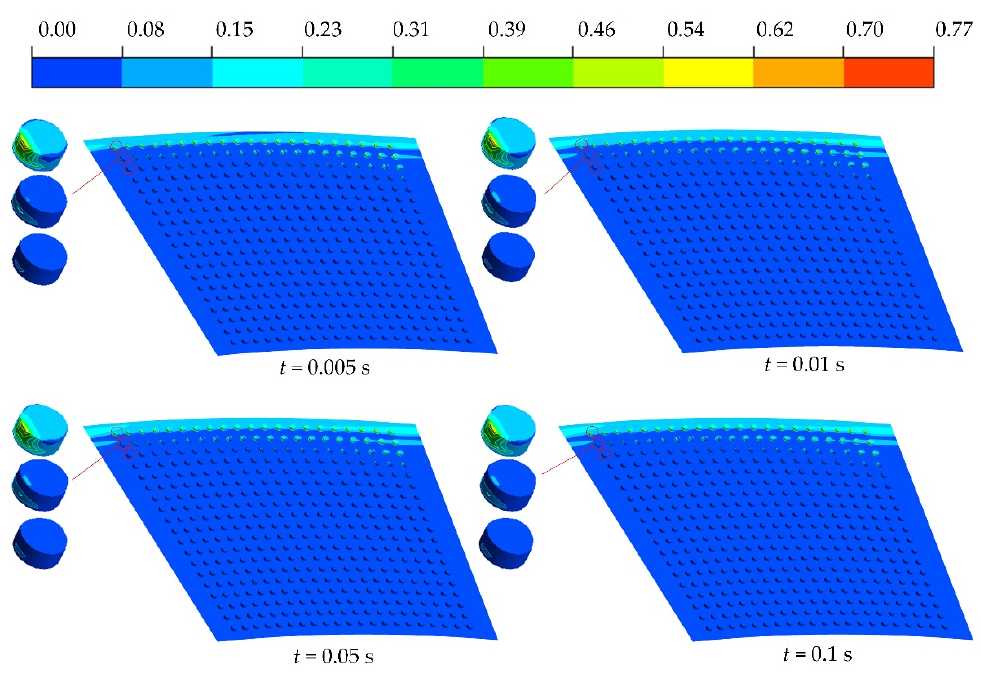
Figure 12. Cavitation morphology evolution when texture rate is 12.917%.